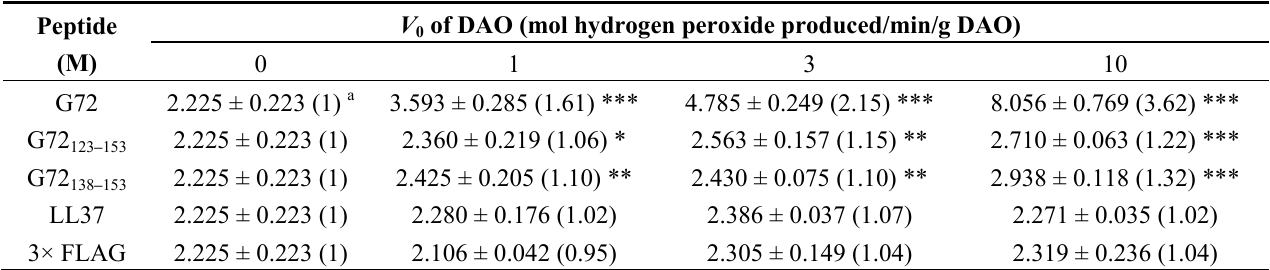
Table 1. Initial velocity ( V ) of DAO in the presence of G72-related or non-related 0